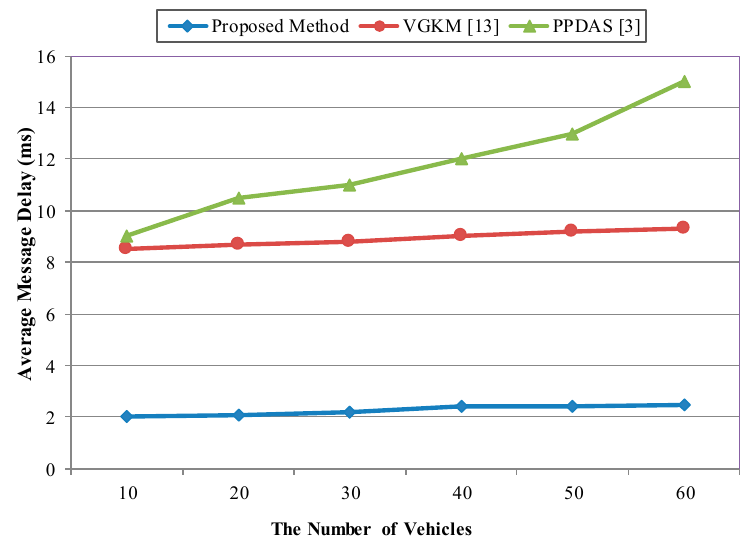
Figure 21. Average message delay vs. number of vehicles.